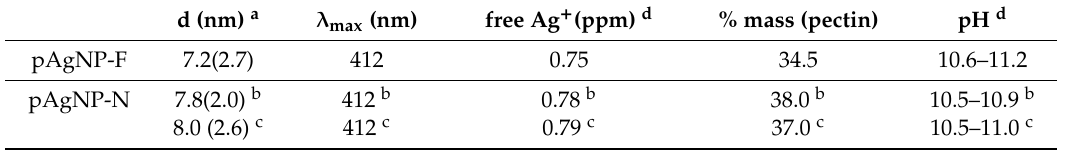
Table 1. Chemical-physical data for pAgNP-F and